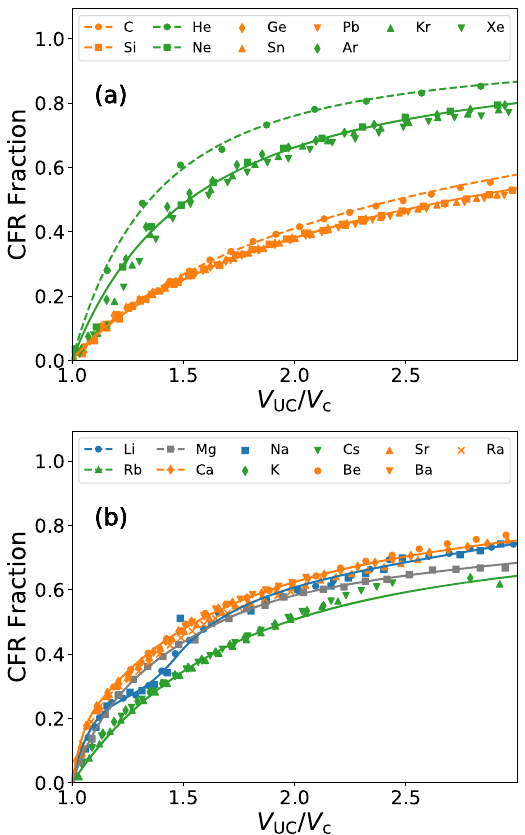
Fig. 5 Periodic trends in CFR evolution under strain. Trends among groups of elements emerge when plotting the CFR fraction against the dimensionless V UC / V c , where V UC is the volume per atom and V c is the fi tted critical volume per atom. All data here were calculated with PBE in Castep. a is for the insulators and b for the